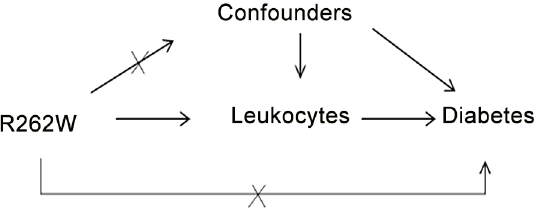
Fig 1. The Mendelian randomization path diagram. The relationship between the instrumental variable R262W, leukocytes (exposure variable), confounding factors and the outcome